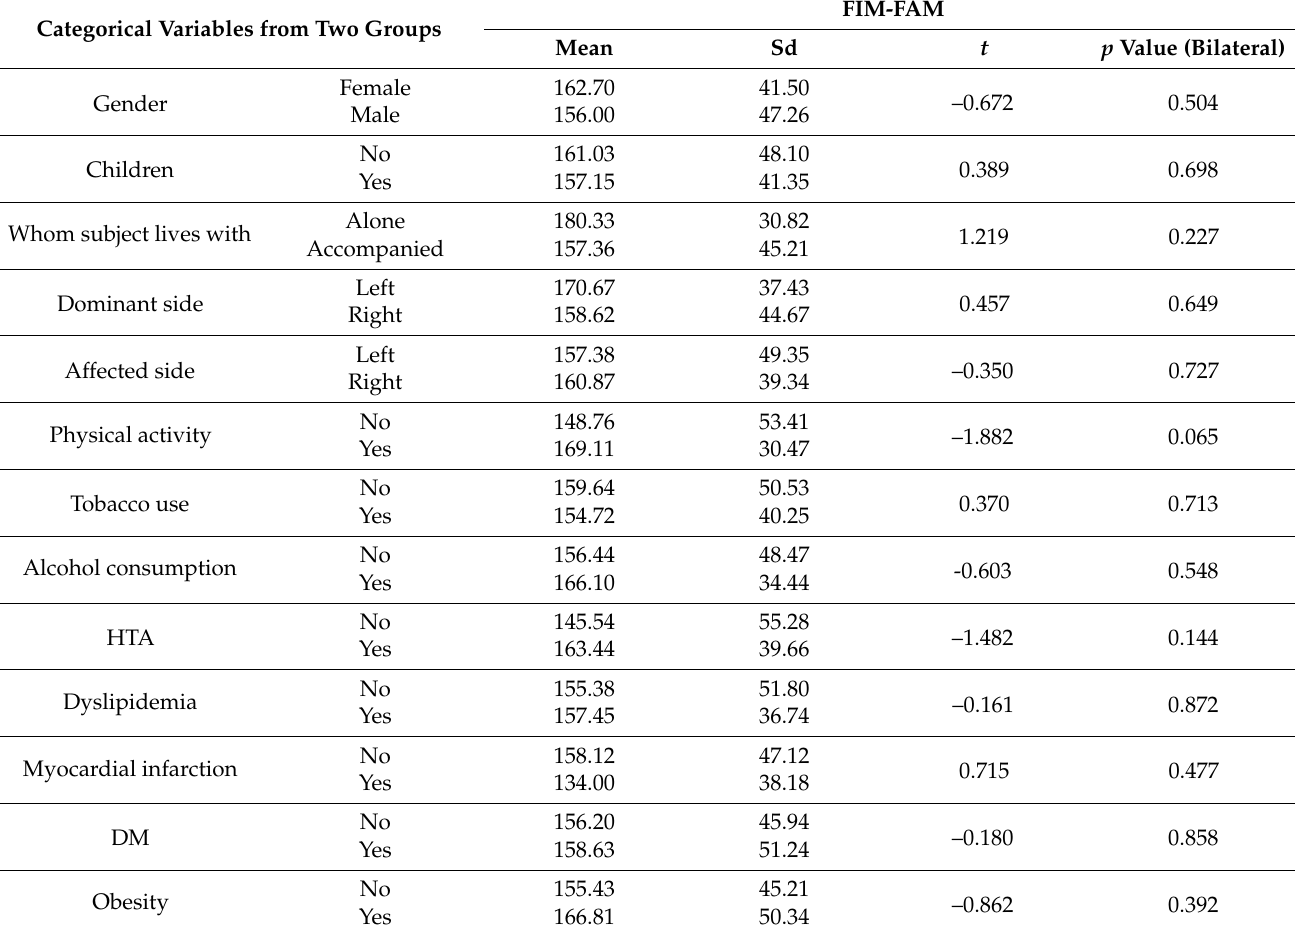
Table 2. Differences between independent study variables of two groups in functional independence using student’s t test for independent